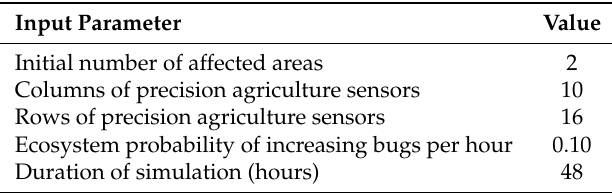
Table 1. Input parameter values of the